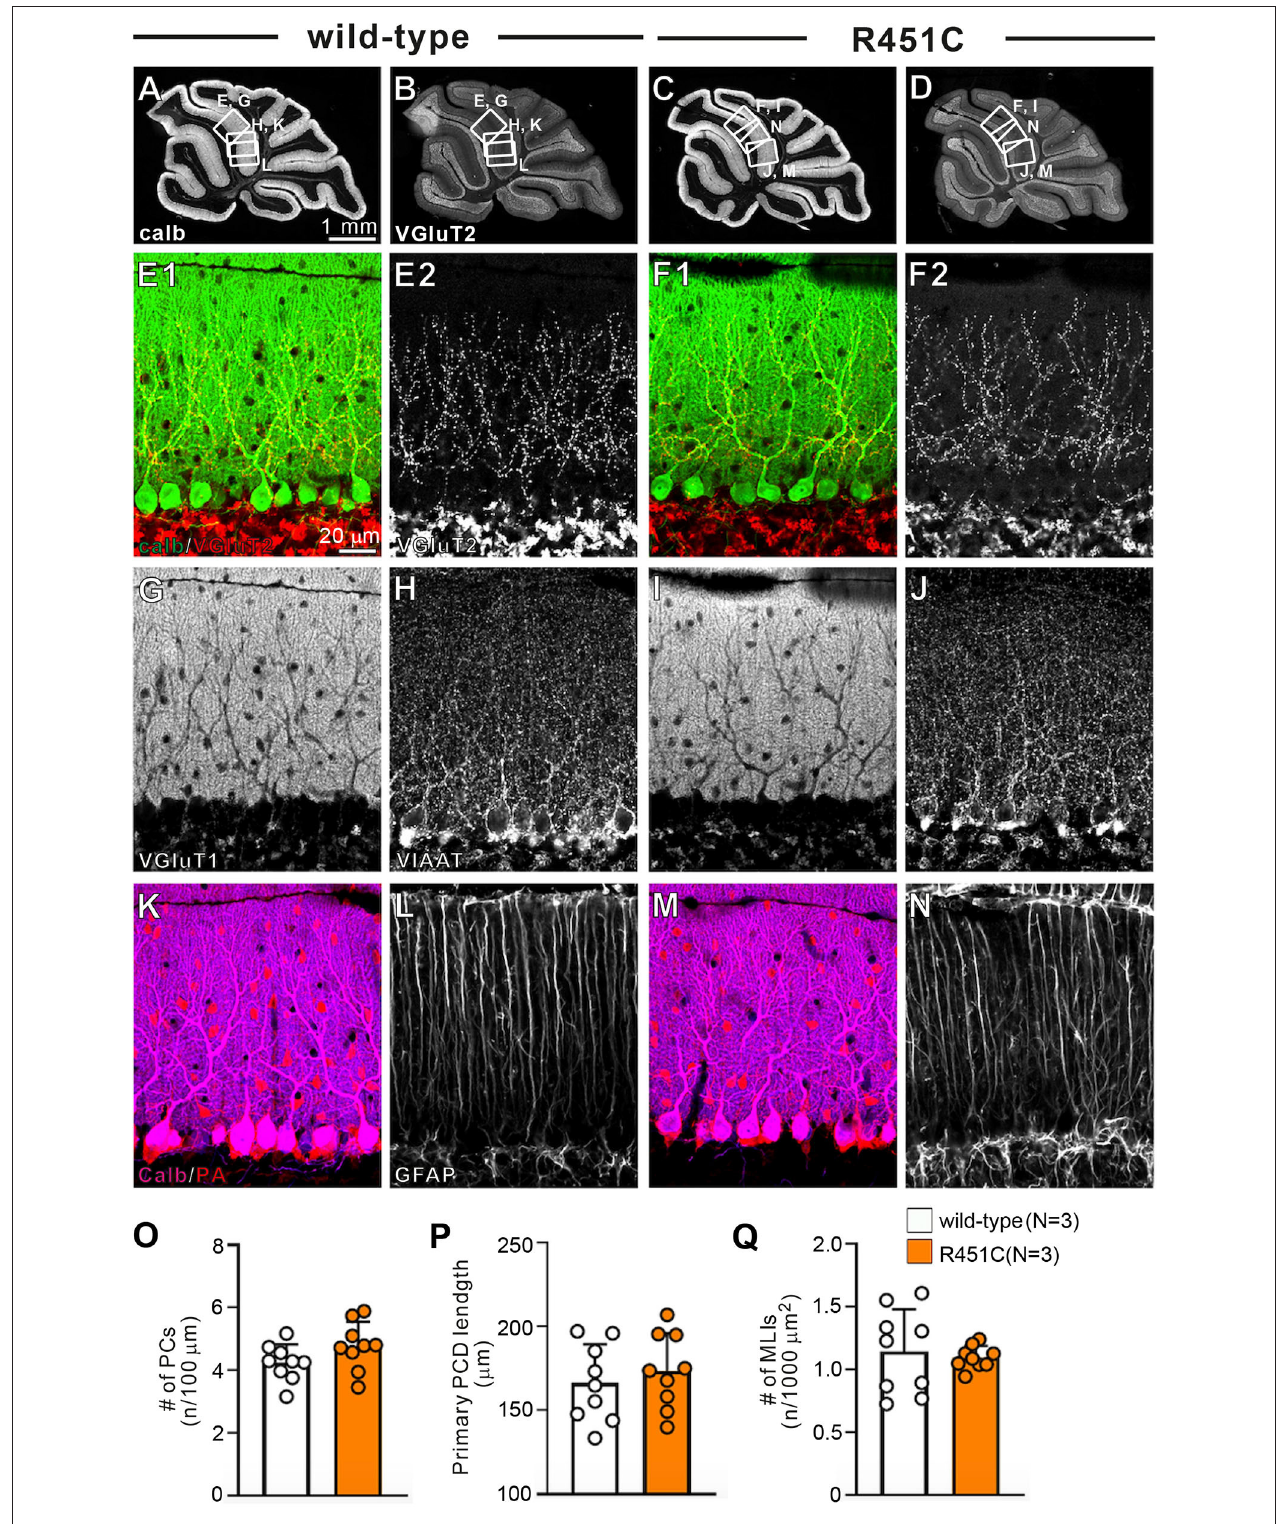
FIGURE 5 | Gross anatomy of the cerebellum, morphology of major cell types, and density of major excitatory and inhibitory synapses appear normal in NLGN3-R451C mutant mice. (A–D) Immunofluorescence for the PC marker calbindin (A,C) and for the CF terminal marker VGluT2 (B,D) of the cerebellum of wild-type (A,B) and NLGN3-R451C mutant (C,D) mice. The boxed regions in (A,B) and those in (C,D) indicate the portions of the cerebellum from which the images